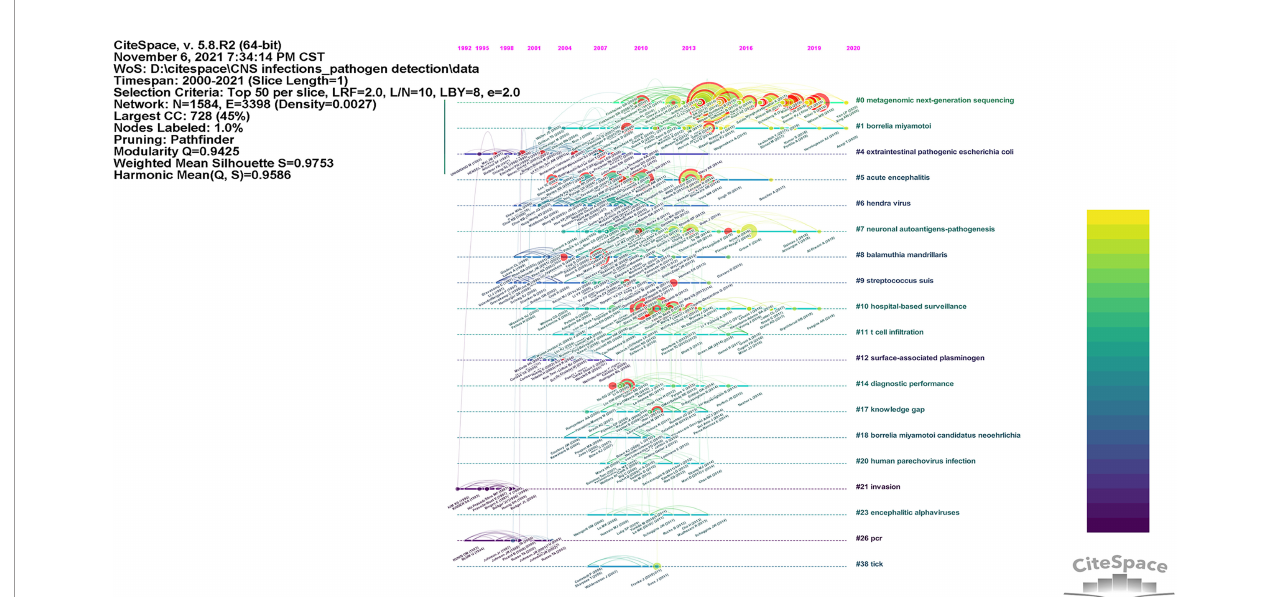
FIGURE 3 | A timeline view of the co-citation clusters. The major clusters are labeled on the